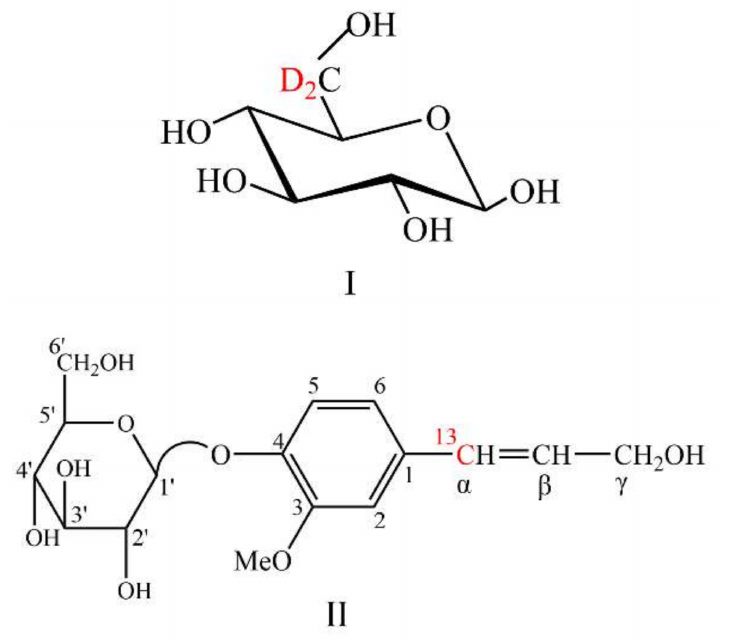
Figure 11. Chemical structures of D-glucose-[6- 2 H 2 ] ( I ) and coniferin-[ α - 13 C] ( II